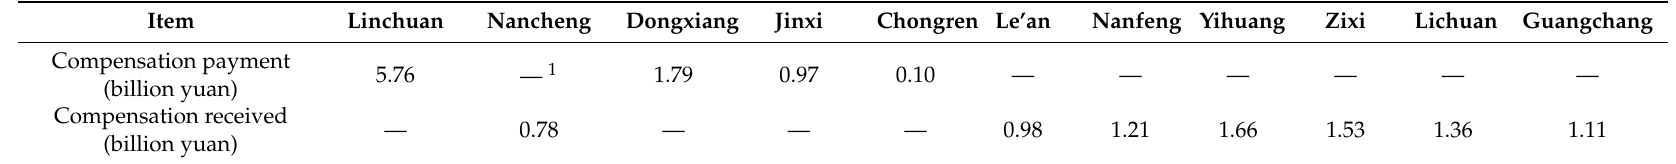
Table 5. The realigning of ecological compensation